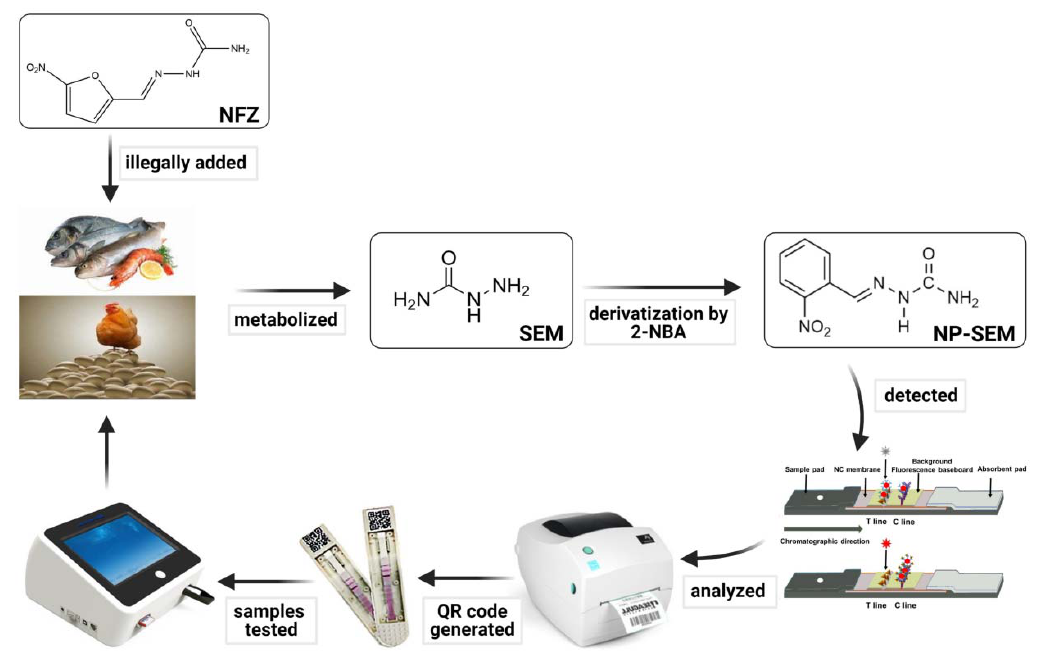
Figure 1. The scheme of bFQICA for detection of SEM in animal ‐ derived foods.